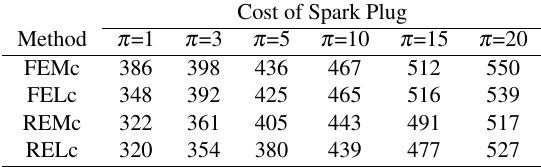
Table 13. Block design for DAP-TC ( π SP is block).